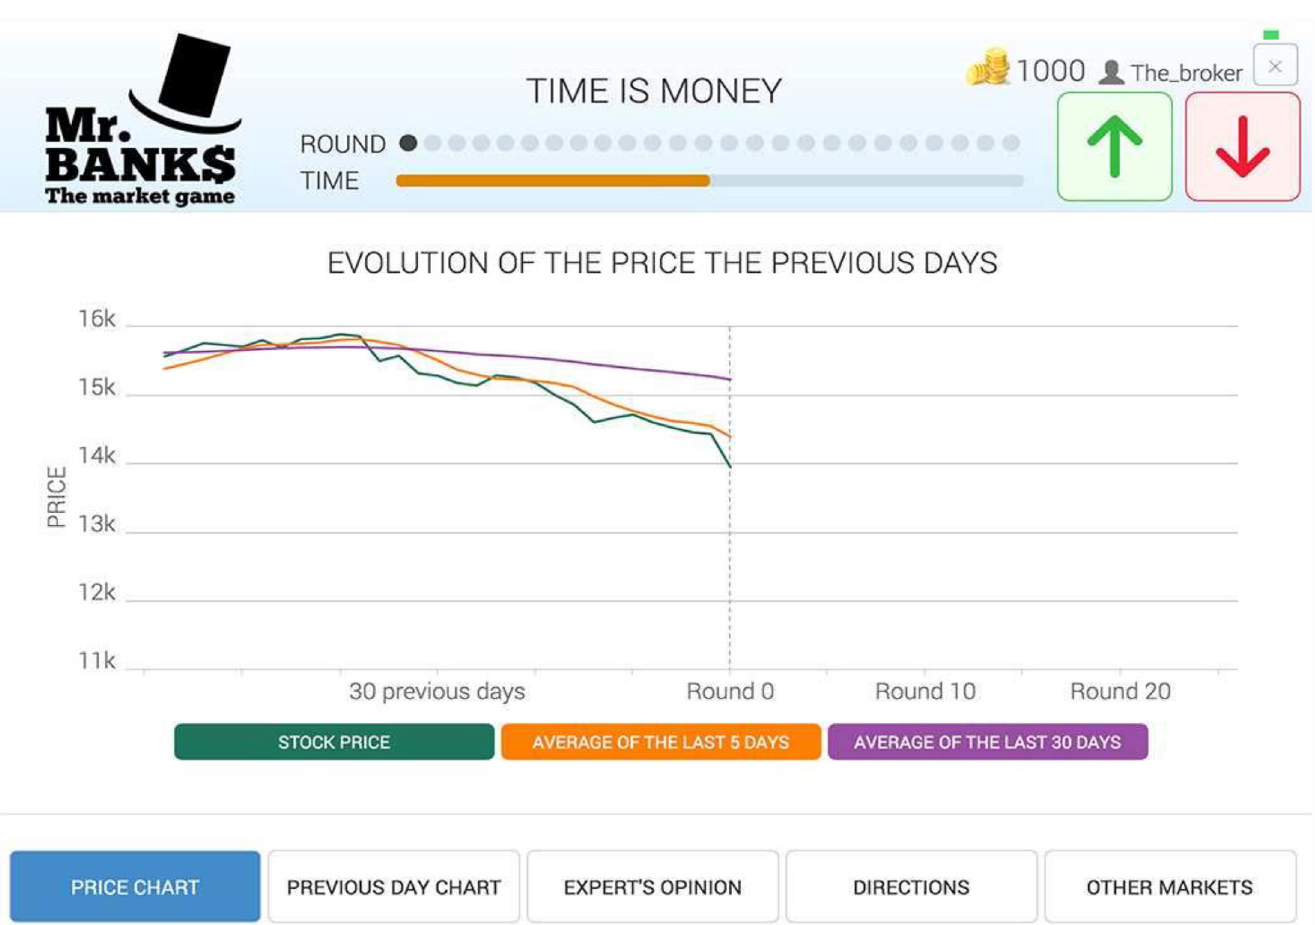
Fig 1. Snapshot of the participant interface. The screenshot shows the home screen with the buttons to select up (green) and down (red). Participants consulted the different types of information available by clicking the buttons placed below the price chart. The top right corner displays the alias of the volunteer and the coins being cumulated during the different rounds. See S1 File for more screenshots of the participant interface.